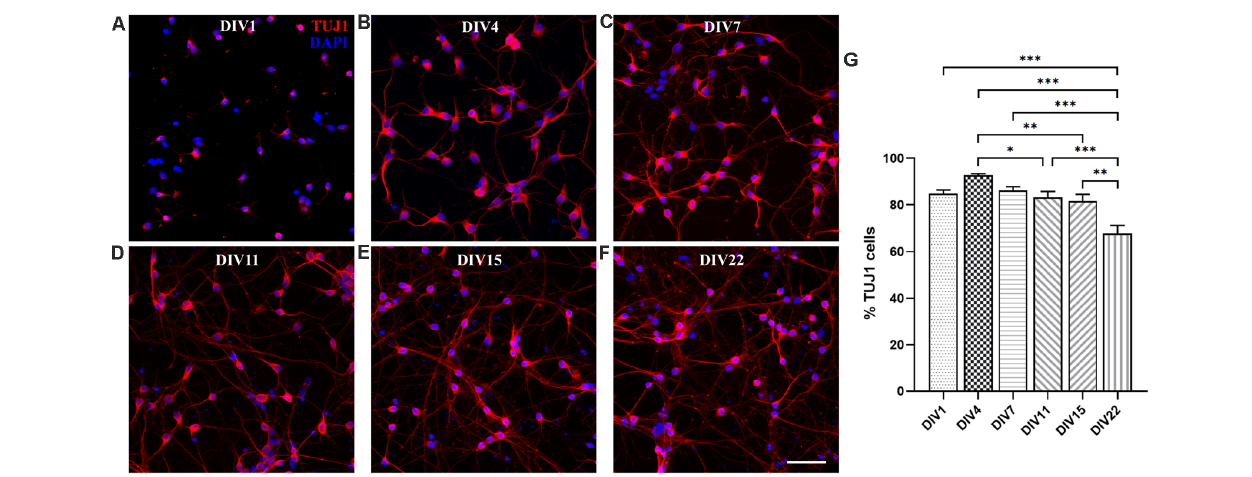
FIGURE 3 | Primary neuronal cultures derived from the P3 to P5 cortex of M. domestica . Neurons were stained for β -tubulin III (TUJ1, red) and nuclei were stained with DAPI (blue). The cells were fixed and stained at (A) DIV1, (B) DIV4, (C) DIV7, (D) DIV11, (E) DIV15, and (F) DIV22, respectively. For better visualization of neurites, the grayscale images are available in Supplementary Figure 2 . (G) Histogram showing percentage of neurons at the times indicated in panels (A–F) . One-way ANOVA followed by Holm–Šídák multiple comparisons test. DIV4 vs. DIV11 p = 0.0395 ∗ , DIV4 vs. DIV15 p = 0.00644 ∗∗ , DIV1 vs. DIV22 p < 0.001 ∗∗∗ , DIV4 vs. DIV22 p < 0.001 ∗∗∗ , DIV7 vs. DIV22 p < 0.001 ∗∗∗ , DIV15 vs. DIV22 p = 0.0013 ∗∗ . Scale bar, 50 µ